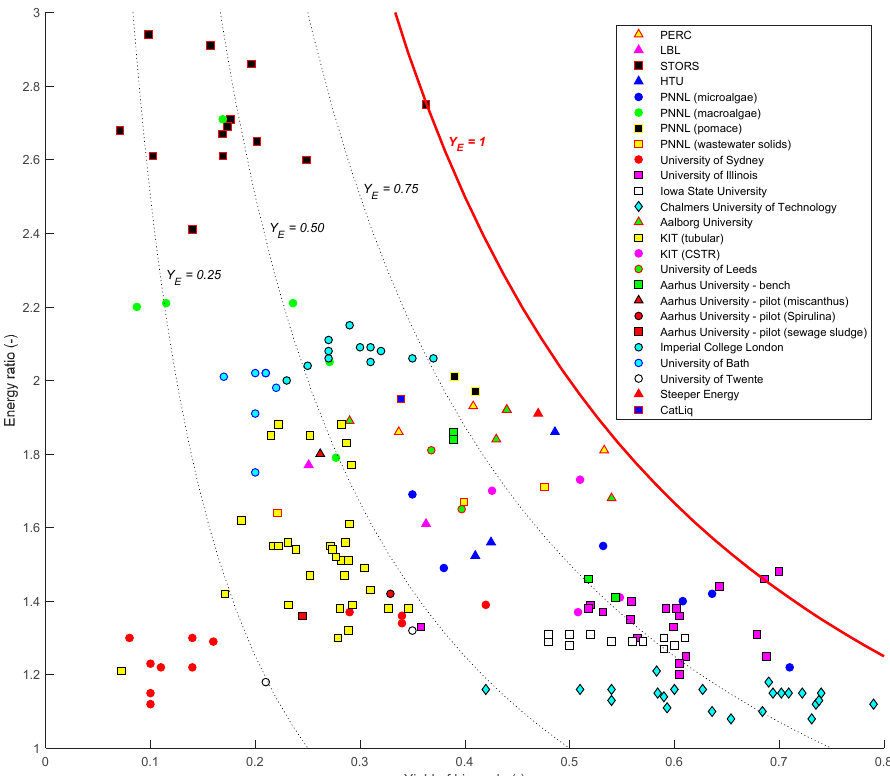
Figure 7. Energy ratio vs. bio-crude yields for the continuous HTL studies in the open literature. Curves represent points with the same energy ratio. Circles: algal biomass; Squares: waste biomass; Triangles: wood; Diamonds: lignin.